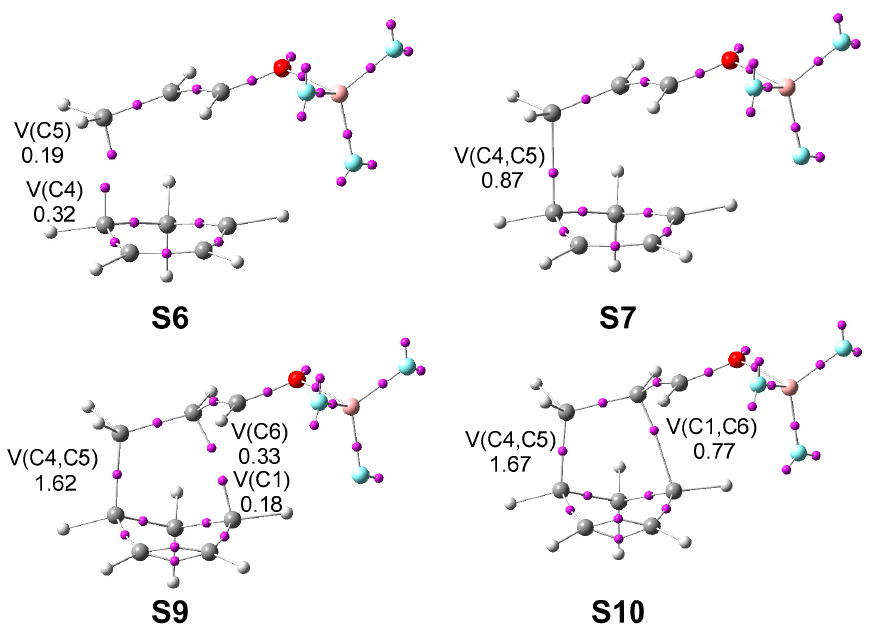
Figure 10. Representation of the ELF attractors of the intrinsic reaction coordinate (IRC) structures involved in the formation of the new C1 − C5 and C4 − C6 single bonds along the endo reaction path associated with the P-DA reaction between Cp 1 and complex 7-BF 3 . The electron populations in average number of electrons, e.